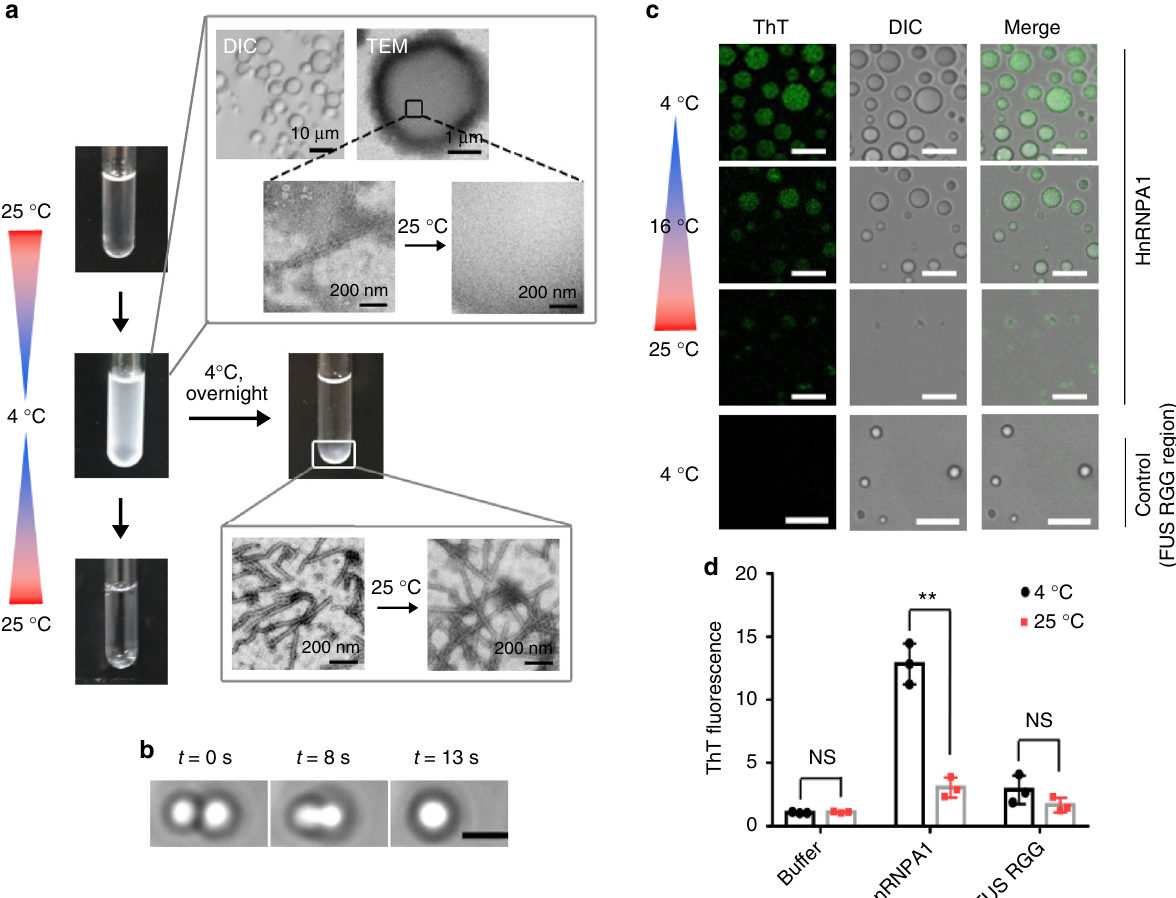
Fig. 1 Phase separation and amyloid fi bril formation of hnRNPA1. a Phase transition of hnRNPA1 upon temperature and time. Liquid-like droplets formed at 4 °C were imaged by DIC microscopy. Amyloid fi brils were imaged by negative-staining TEM. b Representative montage of hnRNPA1 droplet fusion detected by optical tweezers. The scale bar is 2.5 μ m. c In-situ imaging of hnRNPA1 phase separation as temperature increased by DIC microscopy and fl uorescence microscopy. Control images are in the same gray color depth as the hnRNPA1 images. Scale bars are 10 μ m. d ThT fl uorescence of hnRNPA1 and control (FUS RGG) samples at 4 °C and 25 °C was measured by fl uorescence spectrophotometry. Data shown are means ± s.d., with n = 3 independent samples. Values were compared using Student ’ s t test. ** p < 0.01. NS represents non-signi fi cant. Source data are provided as a